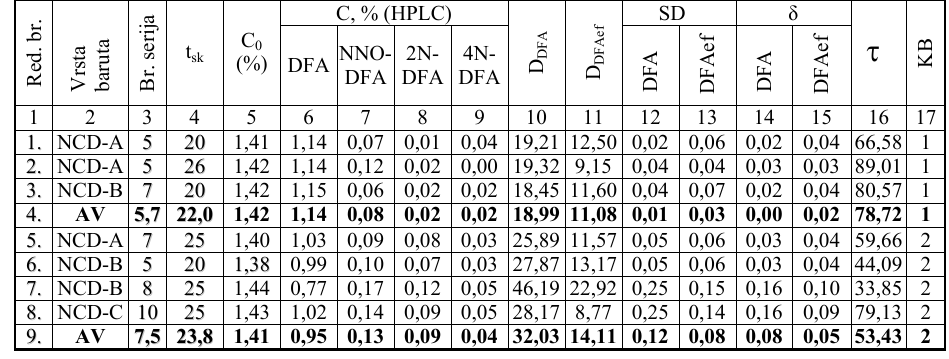
Rezultati ispitivanja sadržaja stabilizatora NCD